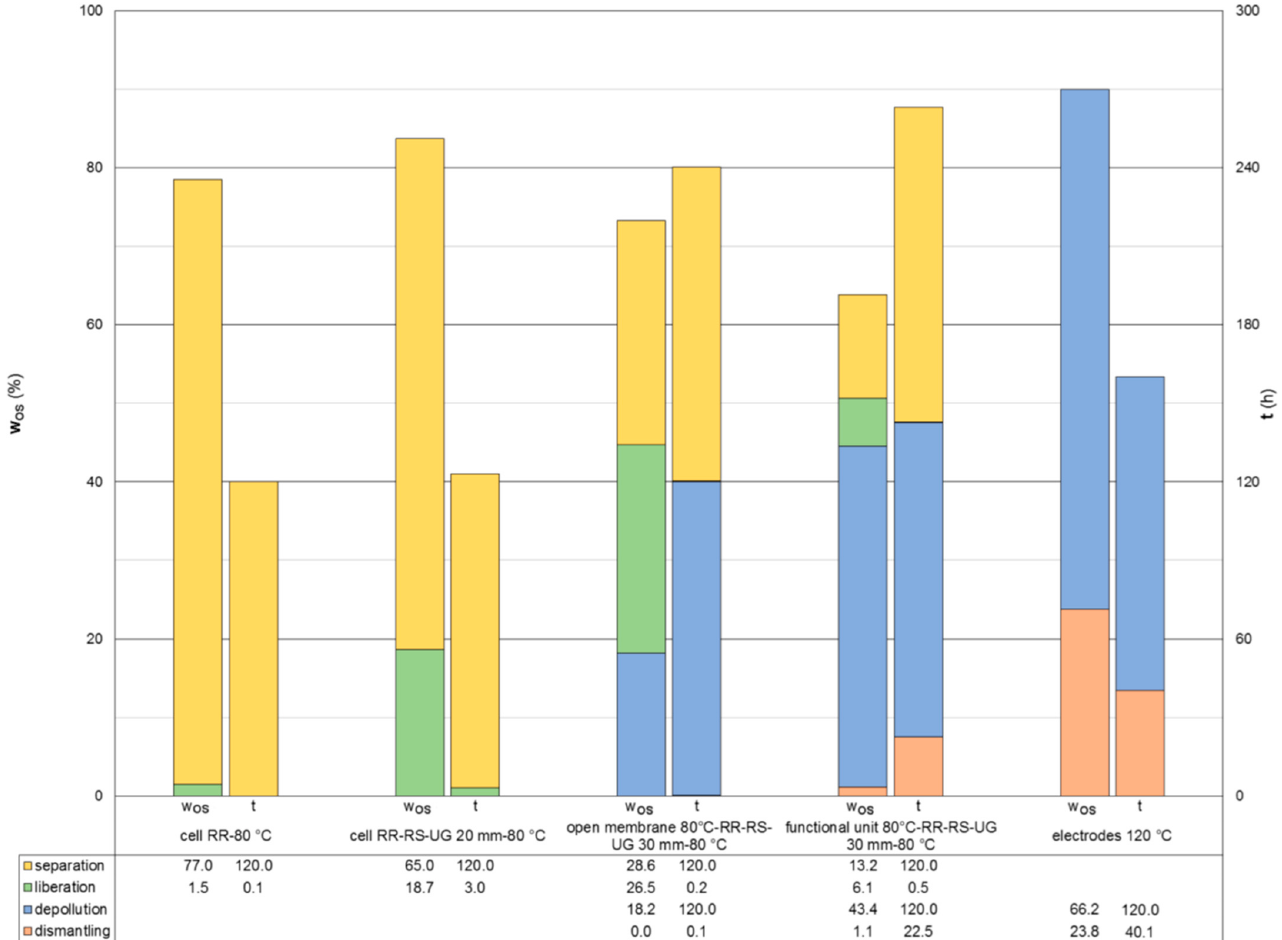
Figure 8. Influence of organic solvent share on process time for different cell opening and organic solvent separation strategies.